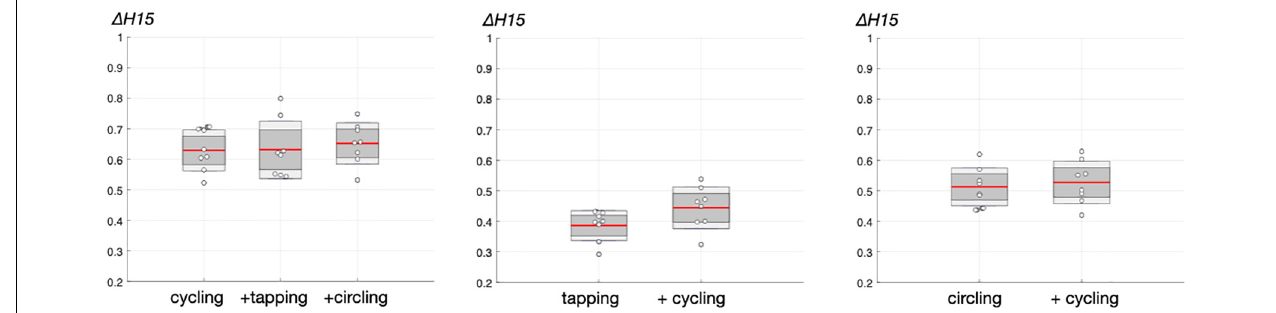
FIGURE 5 | Degree of multifractality in experimental time series, as assessed by (cid:49) H15 (see Figure 3 ). The central mark indicates the mean, dark gray the standard error to the mean (SEM) and light gray the standard deviation. Individual values are represented by “o”